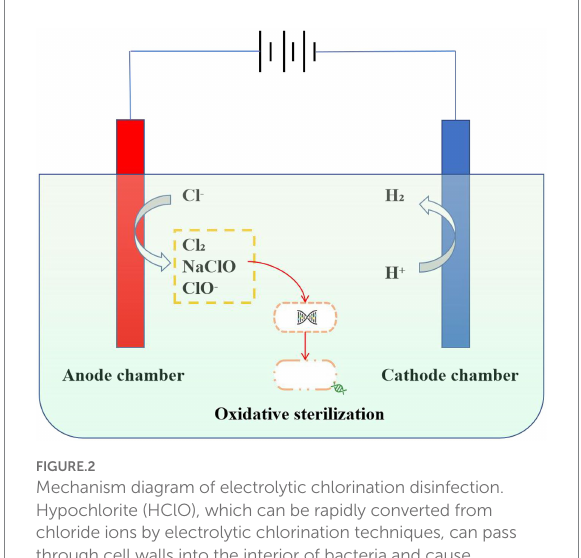
FIGURE.2 Mechanism diagram of electrolytic chlorination disinfection. Hypochlorite (HClO), which can be rapidly converted from chloride ions by electrolytic chlorination techniques, can pass through cell walls into the interior of bacteria and cause microbial death through peroxidation